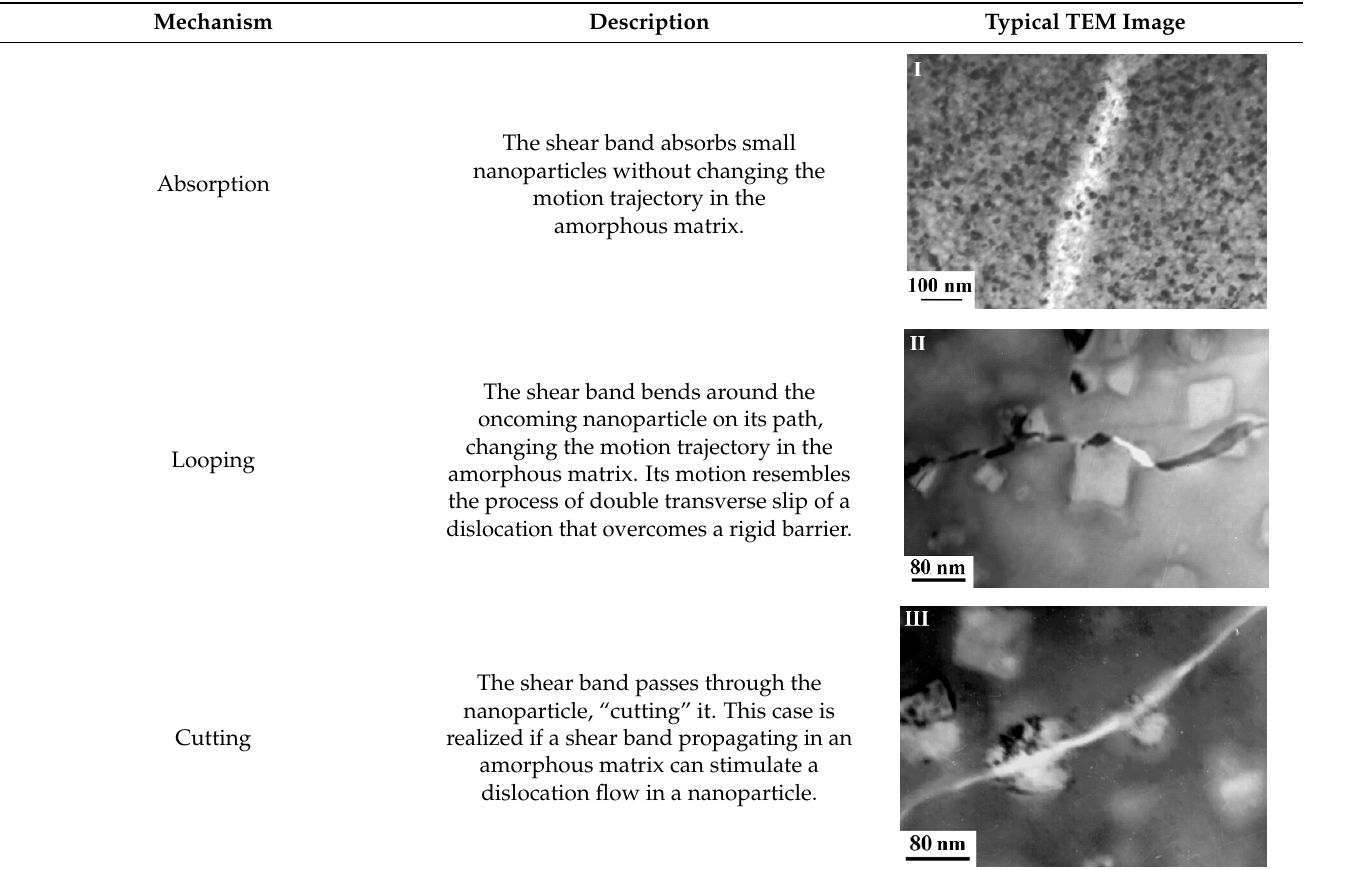
Figure 8. Microhardness as a function of volume fraction of the crystalline phase for all annealing modes of the Fe 50 Ni 33 B 17 AA (solid line) and Orowan’s dependence for crystals (dashed line). Table 2. Classification of mechanisms of interaction between shear bands and nanoparticles in annealed AAs.